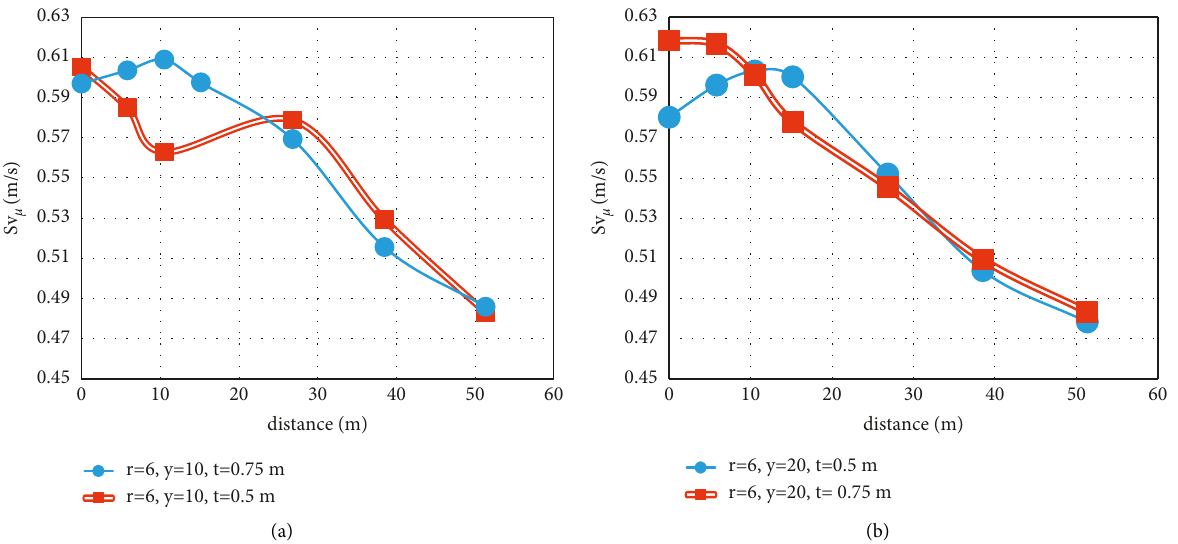
Figure 17: The effect of change in tunnel lining thickness on ground surface velocity for models (a) 12 and 13 and (b) 14 and 15 of Table 1.